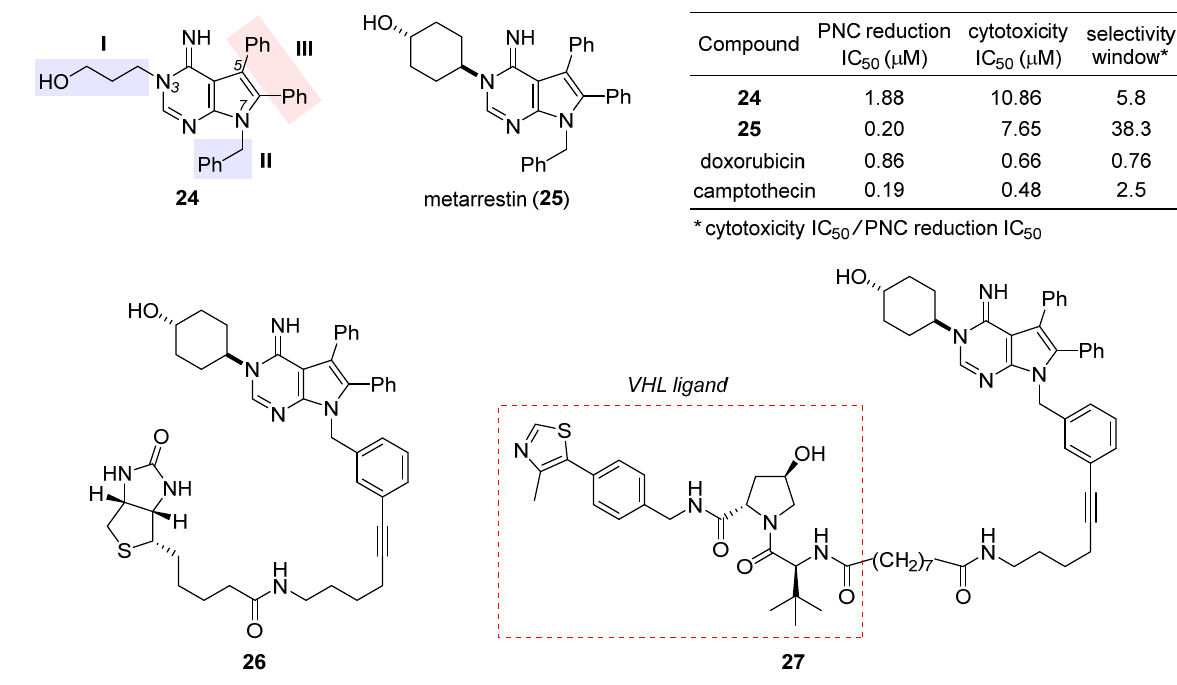
Figure 5. Structures of the initial hit 24 , final drug candidate metarrestin ( 25 ), biotin-labeled affinity probe 26 , and metarrestin-based PROTAC 27 . The inset table compares the selectivity window between PNC reduction and cytotoxicity of 24 , 25 , doxorubicin, and camptothecin.